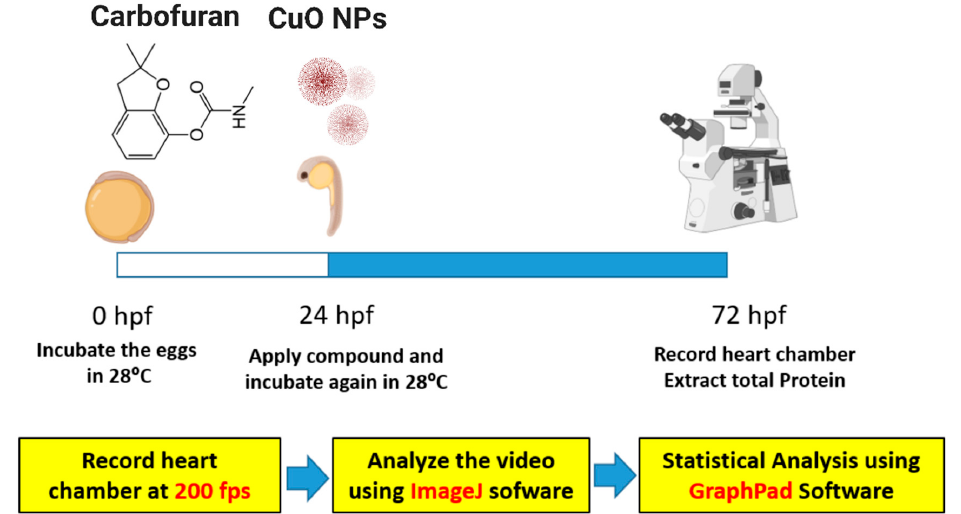
Figure A1. Schematic diagram shows the experimental design for testing cardiac toxicity of CuO nanoparticles and carbofuran on zebrafish larvae. Embryos were exposed to CuO nanoparticles and carbofuran from 24 hpf (hour post-fertilization) onwards and the cardiac performance were assessed at 72 hpf.